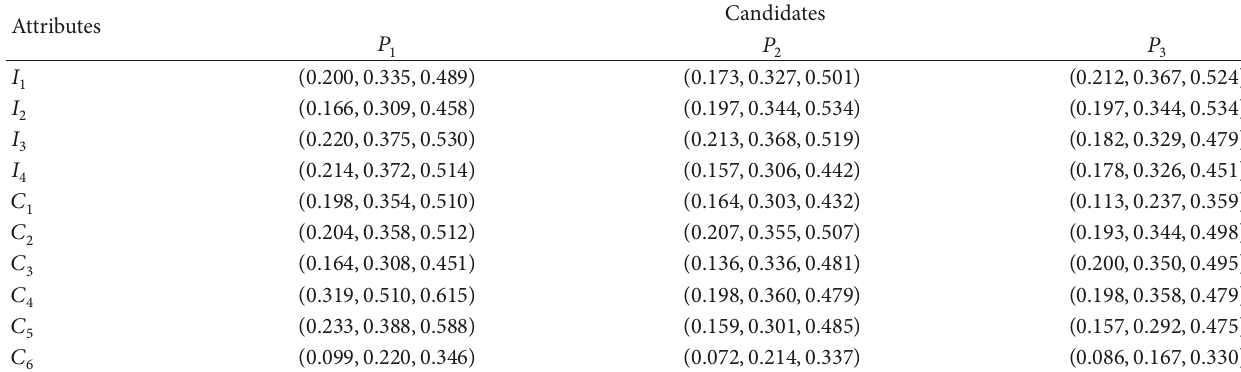
Table 8: The weighted integrated decision matrix.